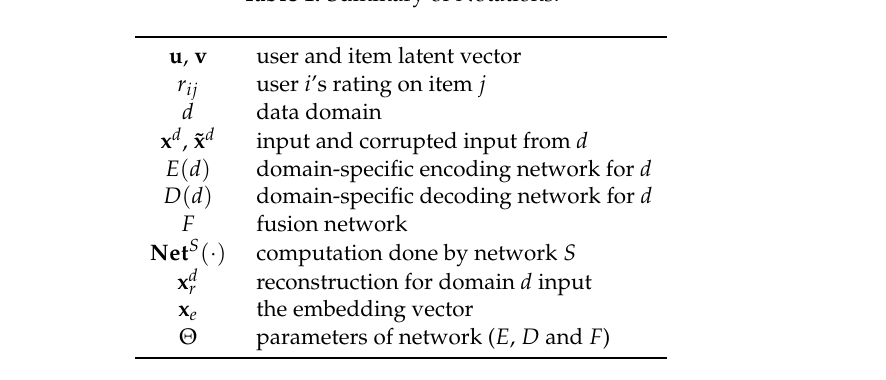
Table 1. Summary of Notations.